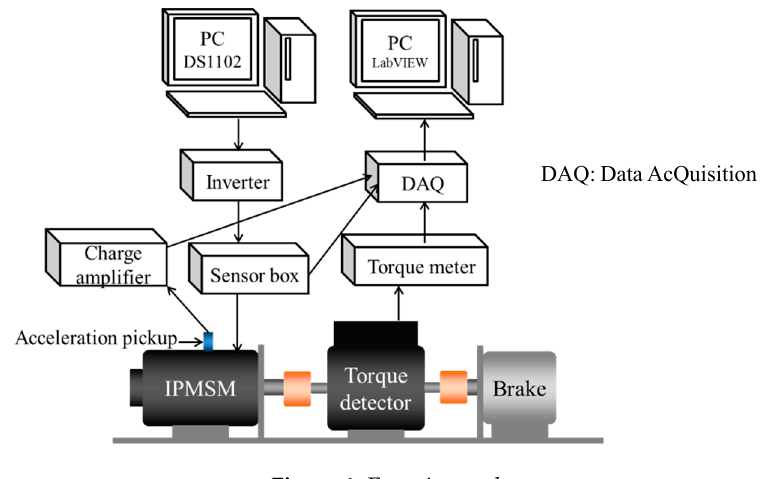
Figure 4. Experimental setup.